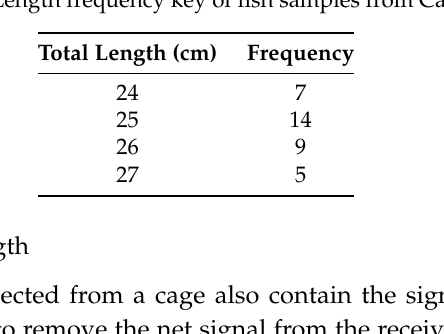
Table 1. Length frequency key of fish samples from